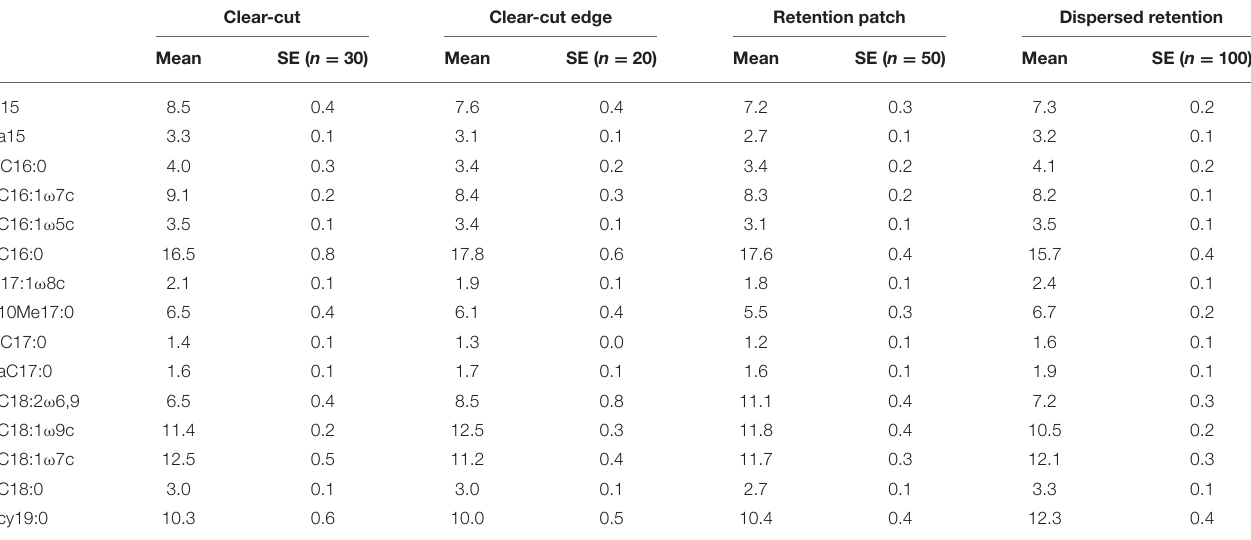
TABLE 1 | Abundance (mol %) of PLFAs in the clear-cut treatment, the clear-cut edge treatment (within 9m of the retention patch), the retention patch and the dispersed-retention treatment. Clear-cut Clear-cut edge Retention patch Dispersed